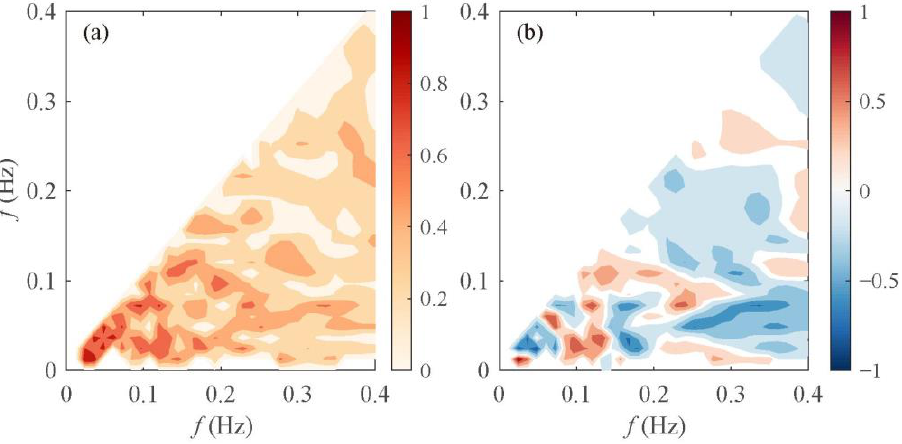
Figure 13. Swash bispectrum of the barred beach (T00B): ( a ) Swash bicoherence, ( b ) imagery part of swash bispectrum.